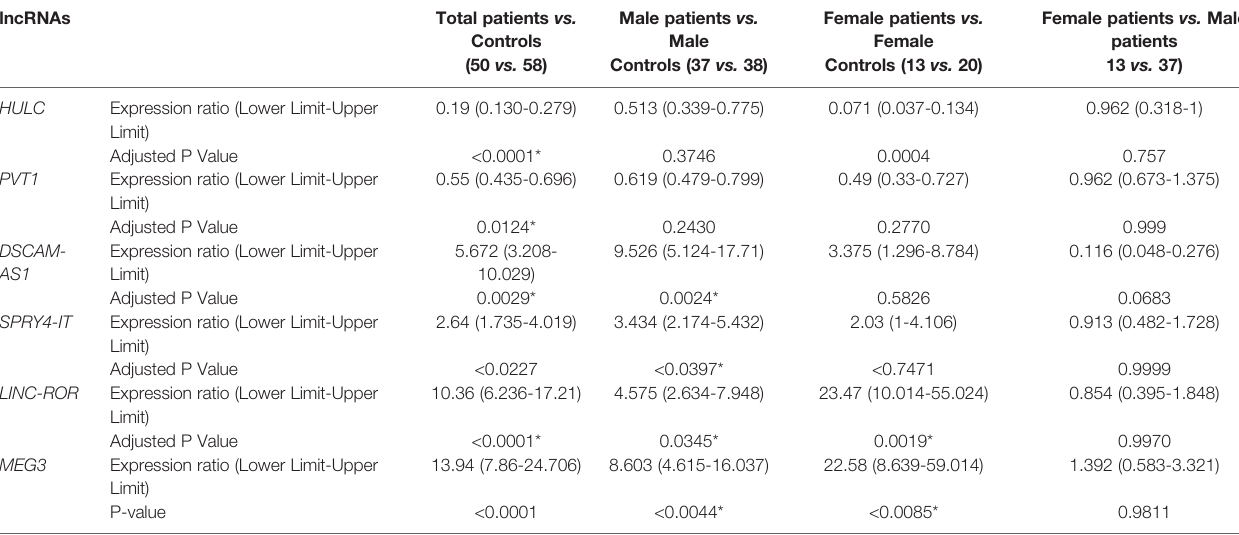
TABLE 3 | The results of expression study of lncRNAs in peripheral blood of patients with PD compared with healthy controls. lncRNAs Total patients vs.